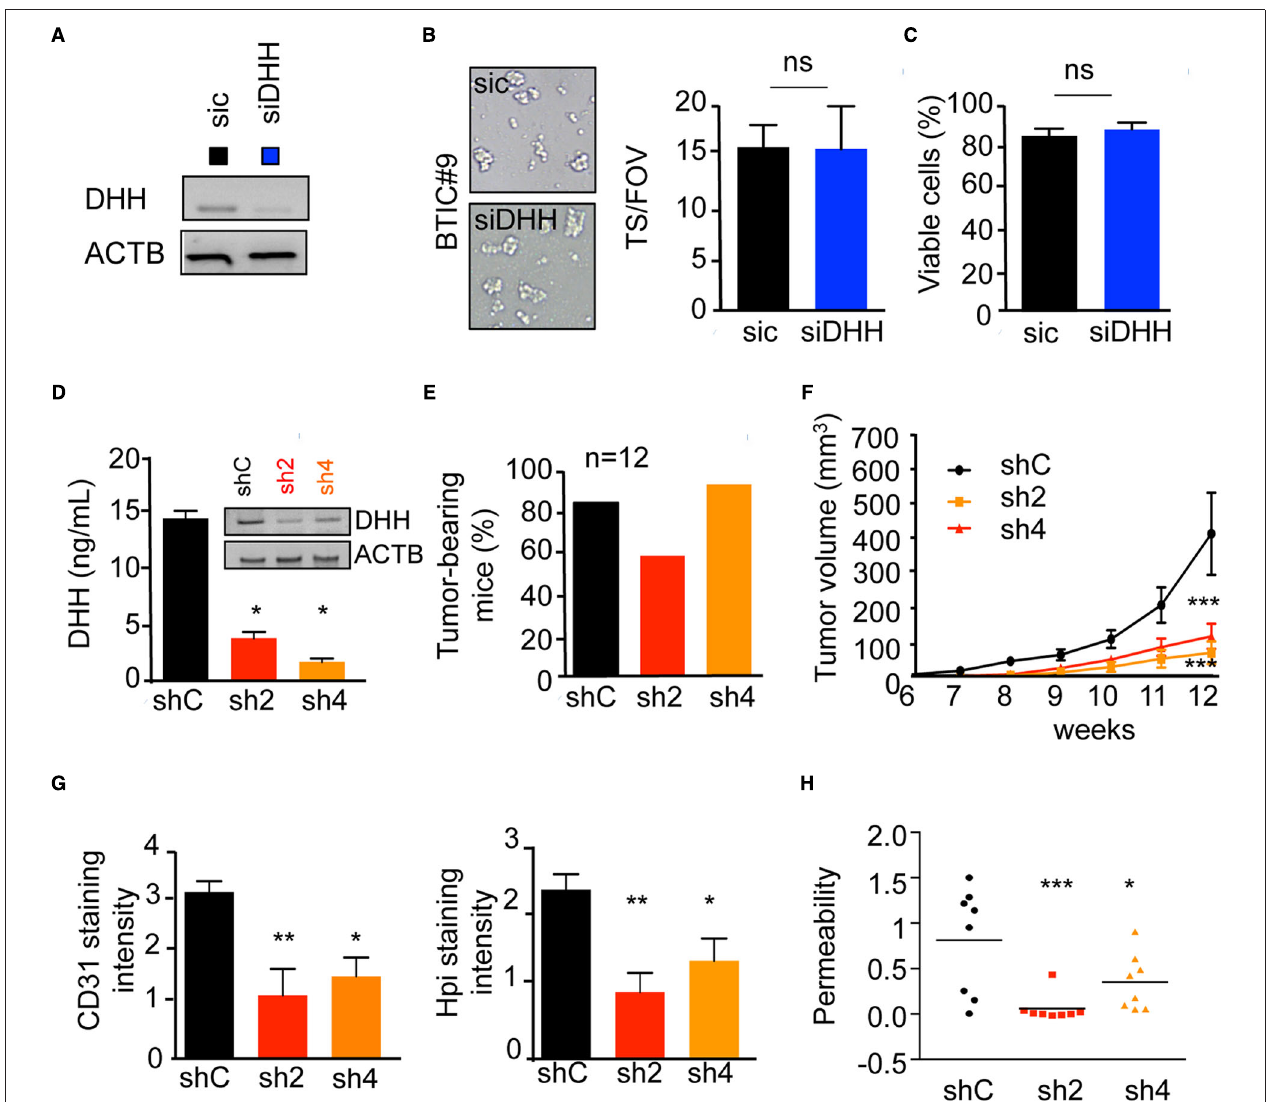
FIGURE 4 | DHH drives vascular dysfunctions in vivo . (A–C) BTIC#9 cells received either control (sic) or siRNA against DHH (siDHH). (A) Cells were processed for DHH expression by RT-PCR. ACTB was used as a reference gene. (B) BTICs cells were tested for their neurospheres formation capacity. Representative images are shown. The number of spheres per field of view (FOV) was quantified. (C) Cell viability was analyzed using trypan blue staining. (D–H) BTICs cells were stably transfected with control (shC) or two shRNAs against DHH (sh2 and sh4) plasmids. (D) DHH expression and secretion was analyzed by RT-PCR and ELISA. (E) BTICs cells were injected subcutaneously in each flank of nude mice, and tumor-baring mice counted 12 weeks later. (F) Tumor volume was evaluated. (G) Frozen tissue sections from obtained tumor xenografts were stained with CD31 and Hpi. Staining intensity was quantified using Image J. (H) Intra-tumor